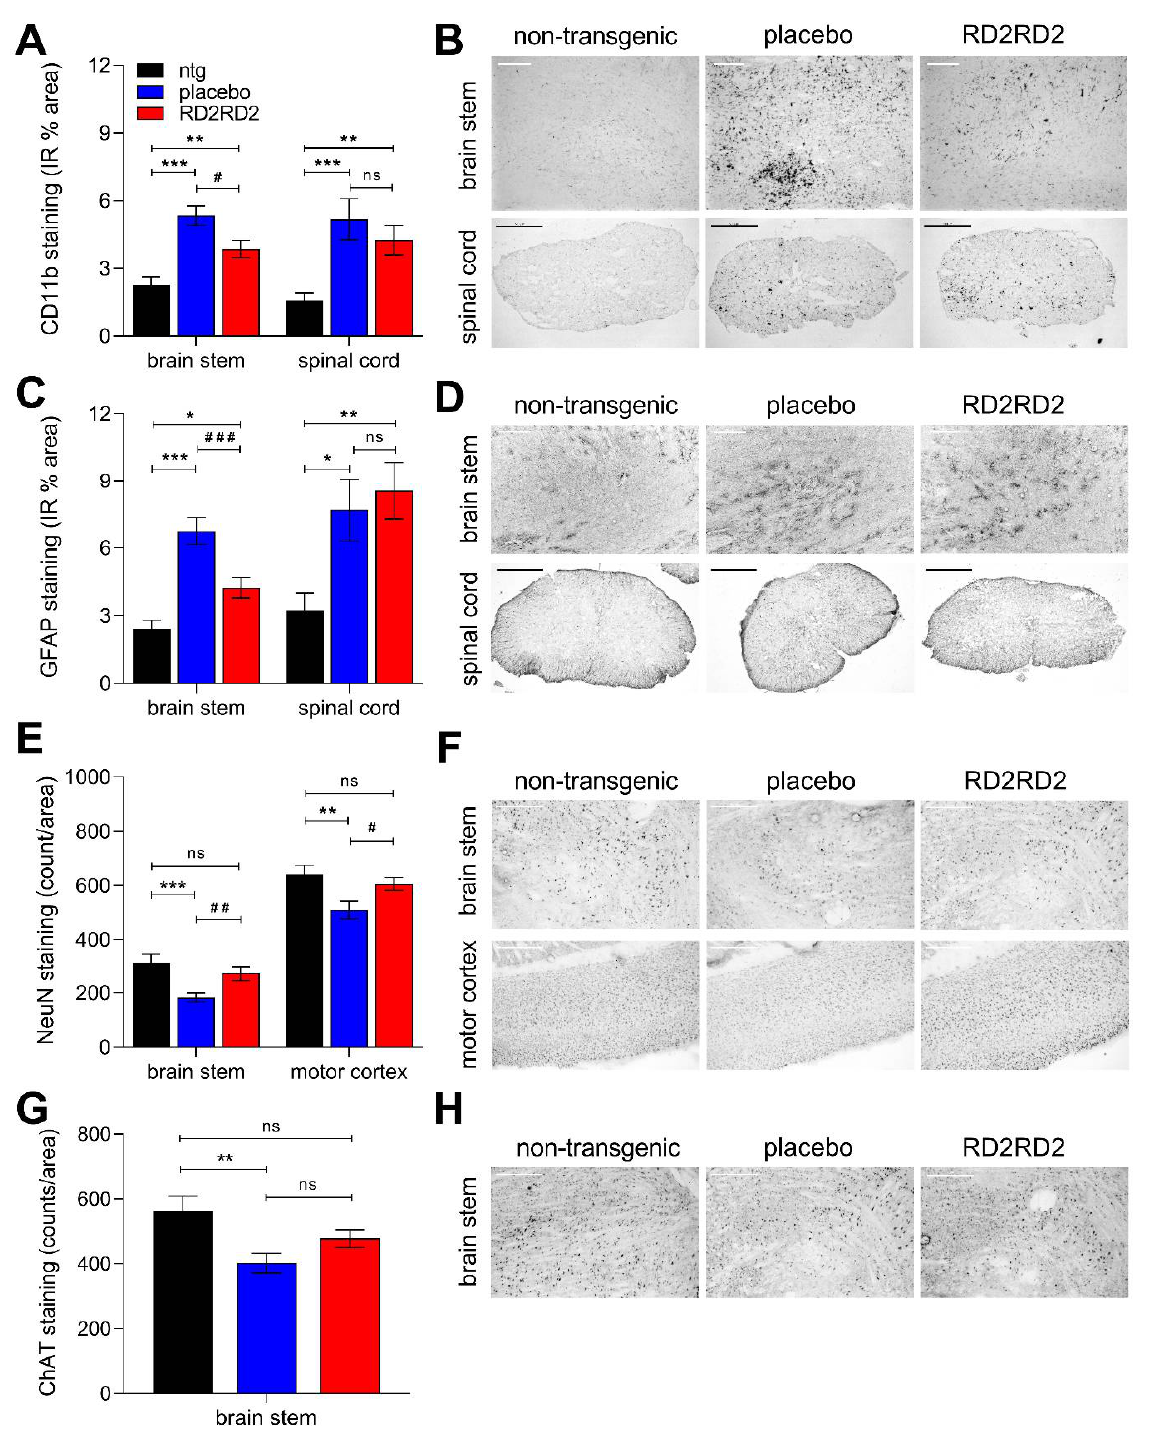
Figure 3. Amelioration of neurodegeneration and neuroinflammation in brain and lumbar spinal cord of SOD1 G93A mice by oral treatment with RD2RD2. Investigations of a potential reduction in either gliosis ( A – D ) or neuron loss ( E – H ) after RD2RD2 treatment were performed using immunohistochemical analysis. Gliosis was analysed by microglia ( A , B ) and astrocytes ( C , D ) staining in the brain stem (scale bar 200 µm) and lumbar spinal cord (scale bar 500 µm). Preservation of neurons was quantified after mature neuron ( E , F ) and motor neuron ( G , H ) staining in different areas of the brain (brain stem and motor cortex, scale bar 200 µm). Data is represented as mean ± SEM. Statistical calculations were conducted by one-way ANOVA with Fisher’s LSD post hoc analysis ( A , C , E , G ). Asterisks (*) indicate significance between non-trans- genic and transgenic treatment groups (ntg vs. placebo or ntg vs. RD2RD2: * p = 0.05, ** p = 0.001 and *** p < 0.001). Lozenges